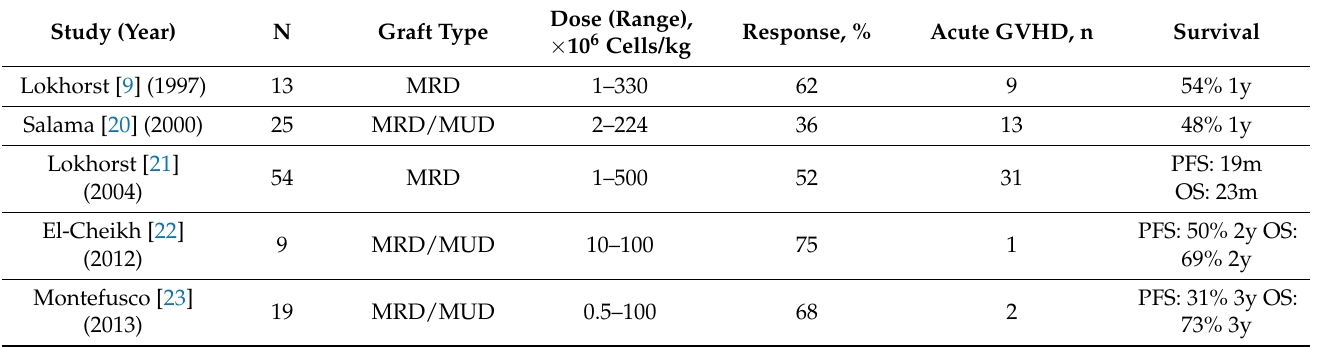
Table 2. Results of salvage